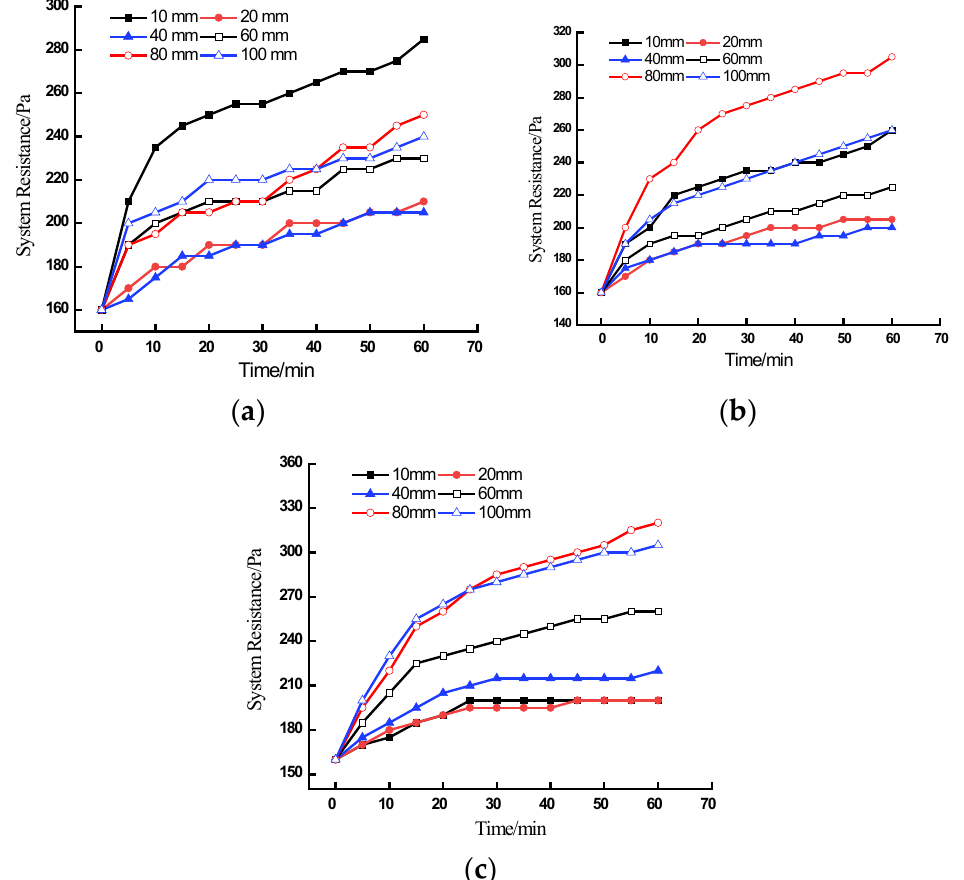
Figure 10. The change in the system operation resistance of the flat cartridge with different nozzle areas and different jet distances at the pulse pressure of 0.4 MPa. ( a ) Total nozzle area of 273 mm 2 . ( b ) Total nozzle area of 546 mm 2 . ( c ) Total nozzle area of 819 mm 2 . Figure 10a,b indicate that the cartridge with a total nozzle area of 273, 546, and 819 mm 2 had the smallest system operation resistance and the best cleaning effect at the jet distance of 40, 20~40, and 20 mm, respectively. Figures 11 and 12 show the system resistance difference and dust residue of the nozzles with different areas at different jet distances at the pulse pressure of 0.4 MPa, respectively.